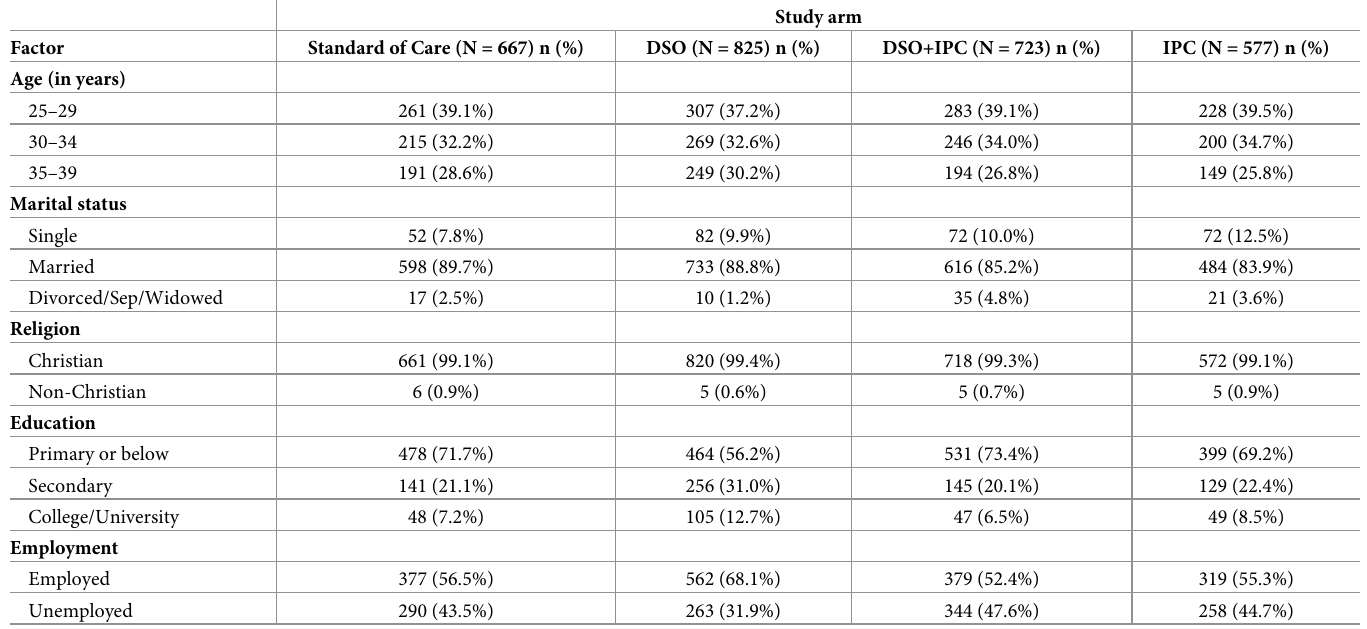
Table 1. Baseline socio-demographic characteristics of uncircumcised men by study arm.